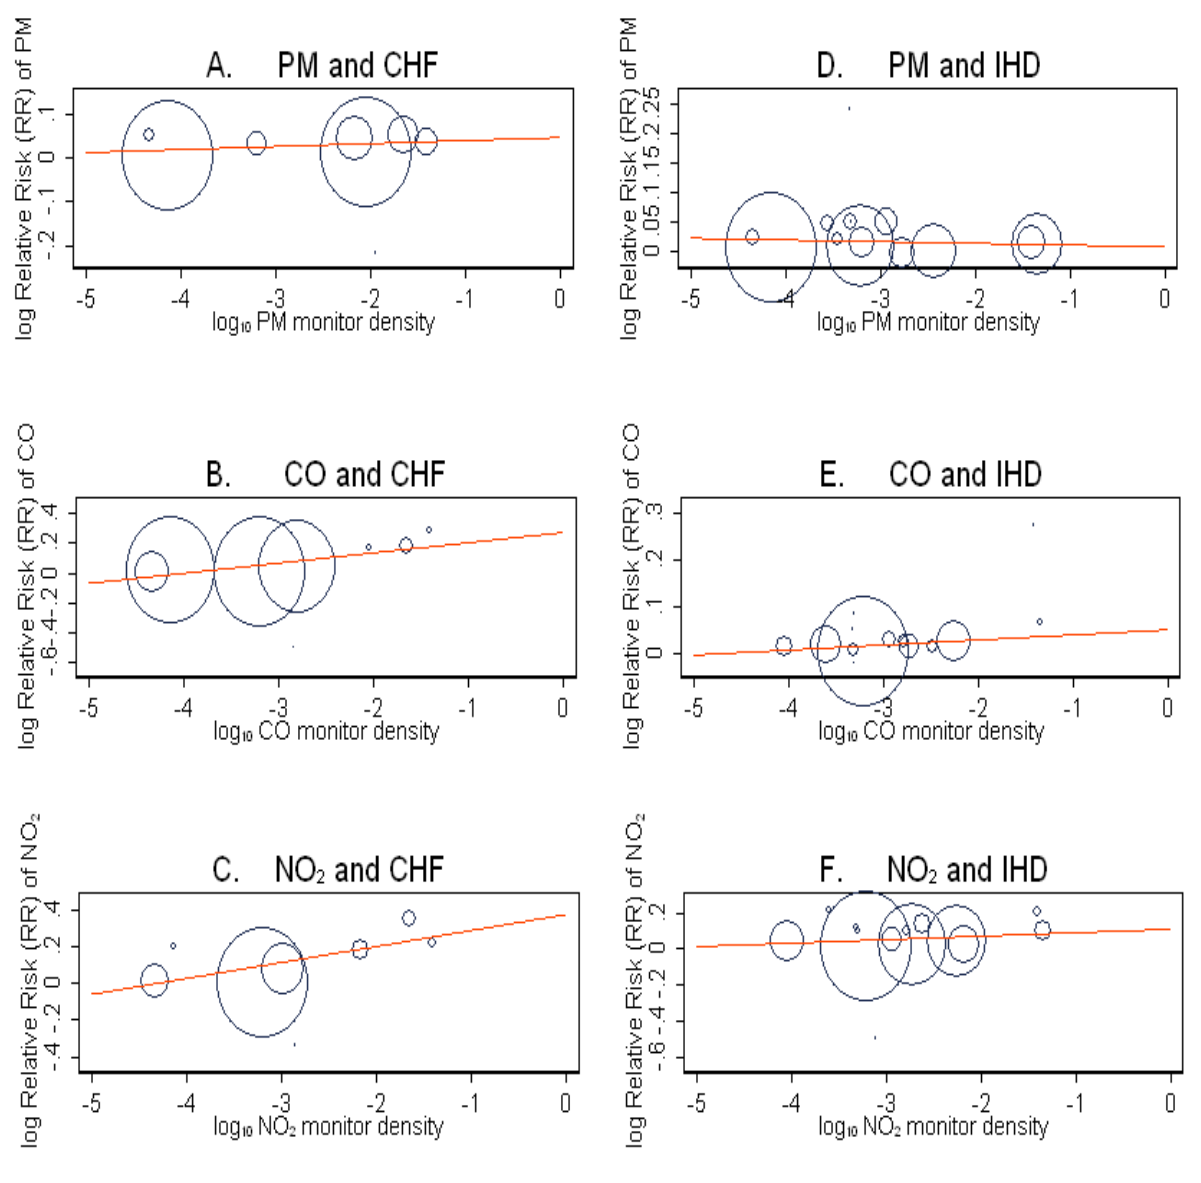
Figure 4. Univariate relationships between the log relative risks (RR) of hospitalizations for congestive heart failure (CHF) and ischemic heart disease (IHD) and in association with exposure to PM ( A and D ), CO ( B and E ), and NO monitor density